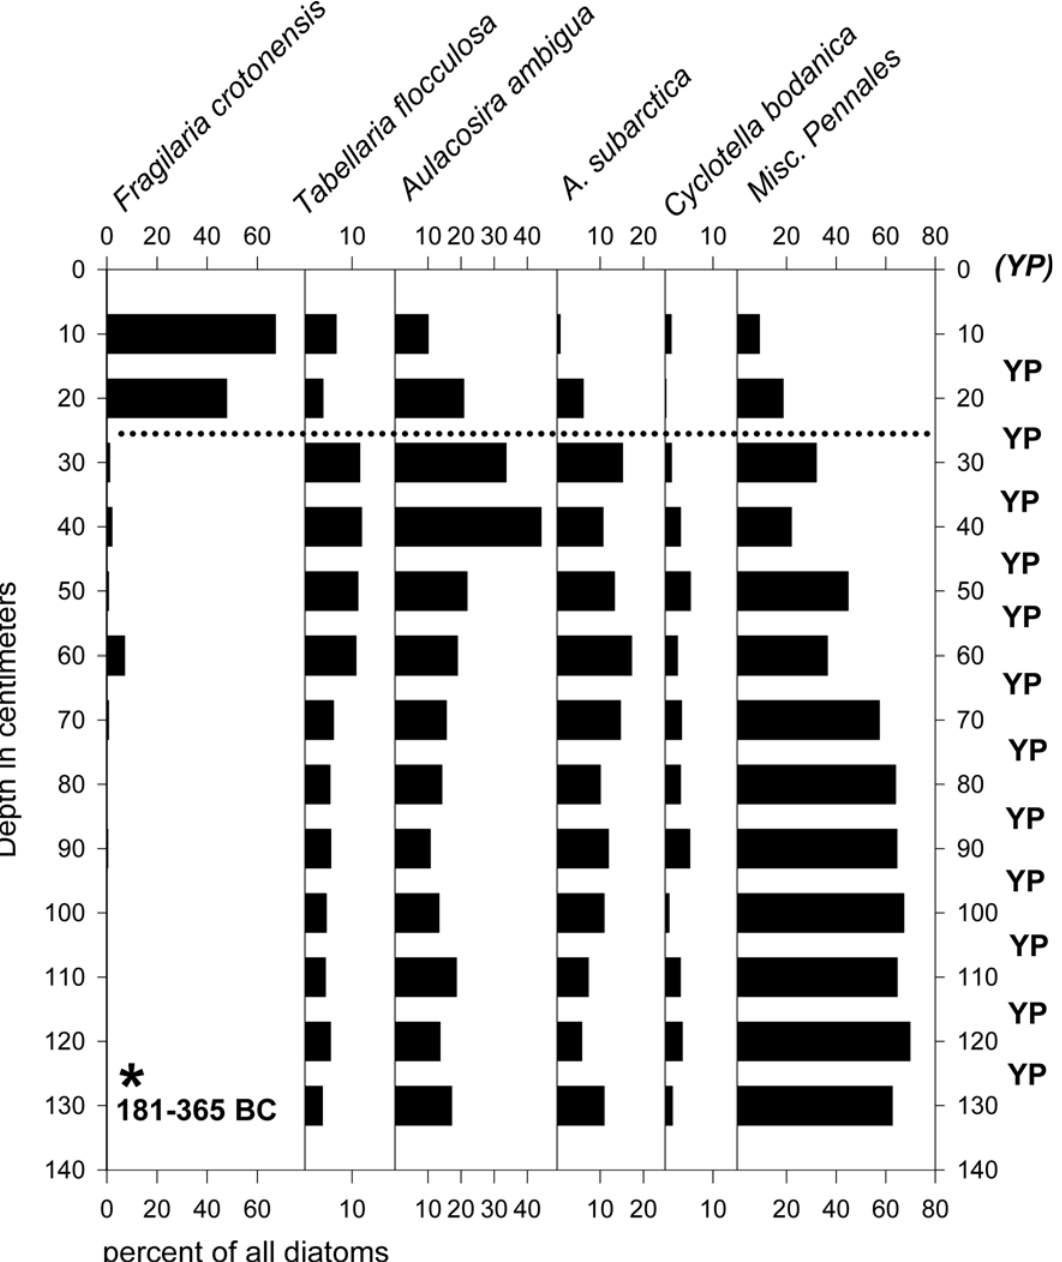
Fig 2. Diatom stratigraphy of sediment core from Lower Saint Regis Lake. Increased Fragilaria crotonensis percentages above the dotted line represents cultural eutrophication in the mid-20 th century and indicates reasonable stratigraphic integrity down-core. Asterisk: calibrated AMS date. YP = sample tested for yellow perch eDNA; all were positive. (YP) = positive yellow perch eDNA sample from modern mud-water interface in an adjacent gravity core.